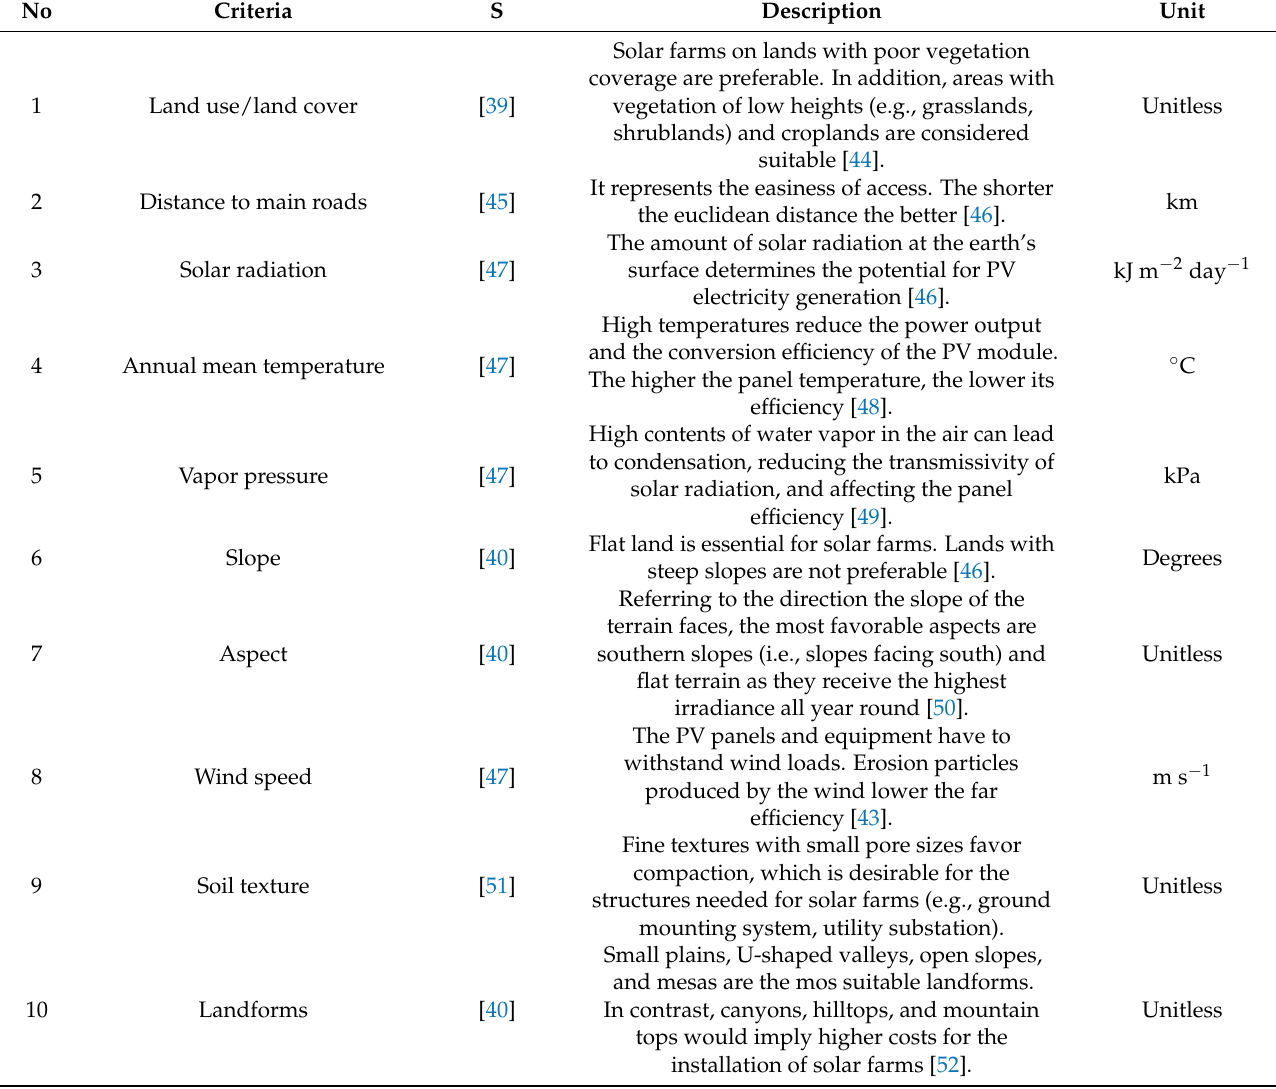
Table 2. Criteria used in the analysis to identify site-suitability for the development of solar